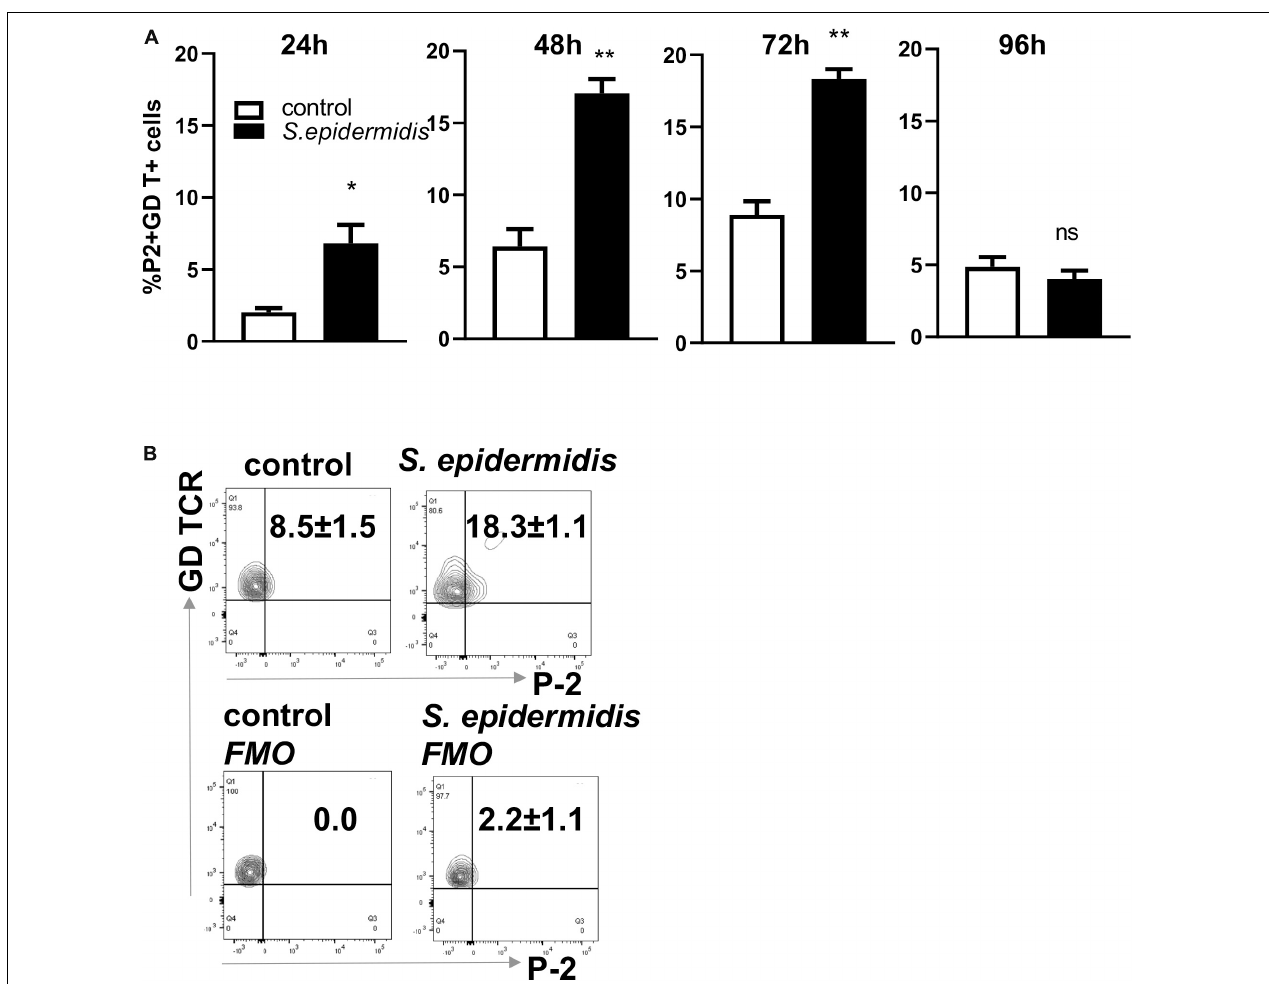
FIGURE 2 | Colonization of human skin with Staphylococcus epidermis induces P-2 in GD T cells. (A) Control and S. epidermidis colonized human skin was collected at indicated time points (24, 48, 72, and 96 h) for FISH-Flow. Single cell suspensions were obtained using Collagenase D and labeled with live/dead stain. Using FISH-Flow RNA assay, P-2 RNA levels were analyzed in the CD45+, CD3+ GD TCR+ cell population. (B) Representative dot plot graph showing expression of mRNA P-2 in gated CD45 + CD3 + GD TCR + T cells at 72 h in S. epidermidis colonized skin or non-colonized (control). FMO-fluorescence minus one. Bar graphs show SEM of P-2 mRNA positive cells within skin GD T cells ( n = 3). Data represent at least two technical replicates with three independent biological replicates per group. * p < 0.05, ** p < 0.01 as calculated using Student t